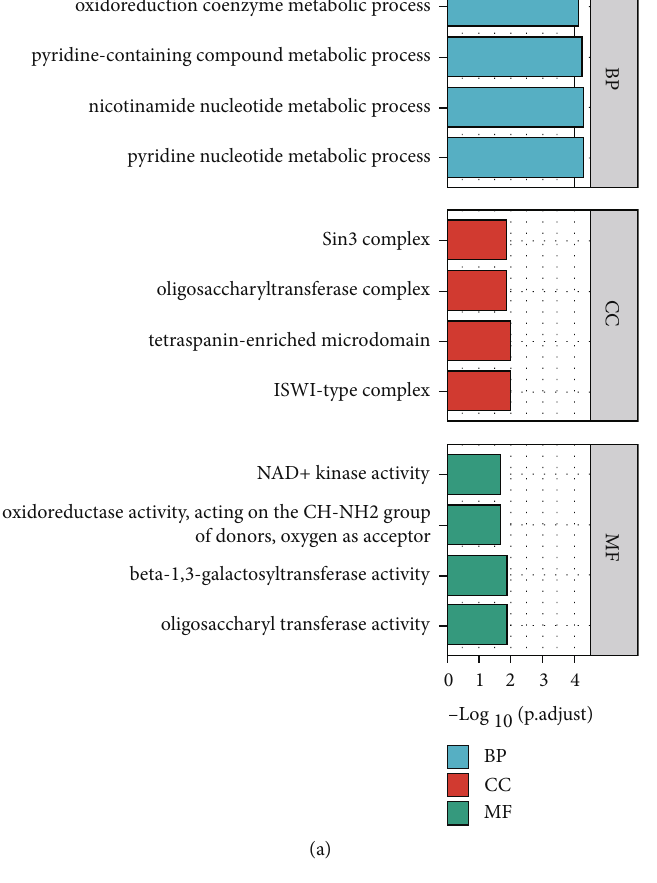
Figure 4: GO (a) and KEGG (b) analysis of the 25 intersected